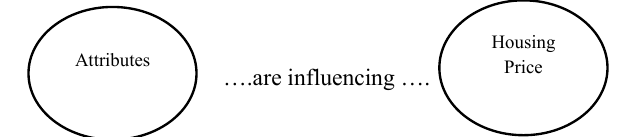
Fig. 2. Questionnaire Model for Comparing Preferences